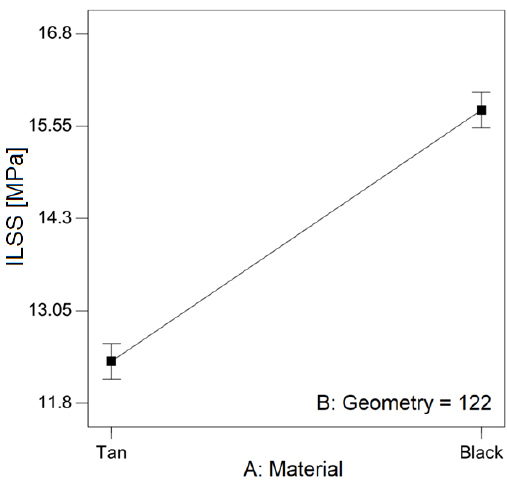
Figure 13. Effects diagram for SBS test. Figure 13. E ff ects diagram for SBS